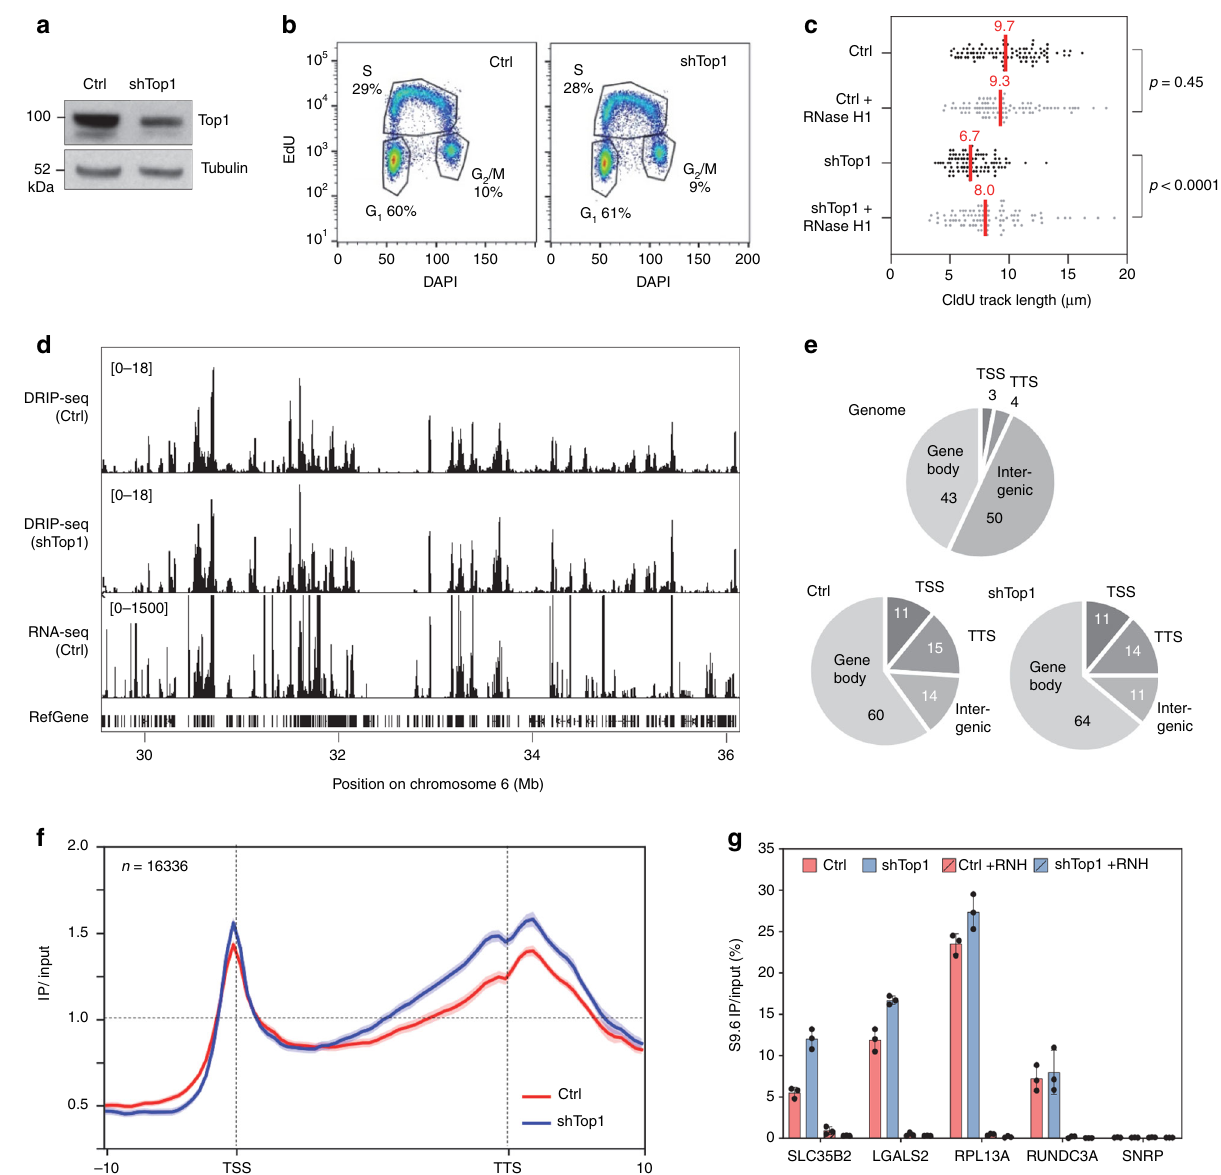
Fig. 1 Depletion of Top1 increases R-loop formation and slows down fork progression. a Western blot analysis of Top1 levels in HeLa cells expressing shRNA targeting Top1 (shTop1) under the control of a doxycycline-inducible promoter at 72 h post-induction ( n = 9). b Cell-cycle distribution of control and shTop1 cells determined by fl ow cytometry after labeling of S-phase cells with EdU. The fraction of cells in the different cell-cycle phases is indicated. See Supplementary Fig. 7 for gating strategy. c Doxycycline-treated control and shTop1 HeLa cells were transfected for 48 h with a mock vector (EGFP-N1) or human RNase H1-EGFP ( + RNase H1) and were sequentially labeled with IdU and CldU for 20 min. Replication fork progression was measured using DNA fi ber spreading as described in “ Methods ” section. The median length of CldU tracks is indicated in red. At least 150 fi bers of each sample were measured ( n = 3). P -values were calculated with the two-sided Mann – Whitney rank-sum test. d DRIP-seq analysis of the distribution of RNA:DNA hybrids expressed in RPKM (Read Per Kilobase per Million reads) in control and shTop1 HeLa cells. A representative region on chromosome 6 is shown. RNA-seq data (RPKM) for HeLa cells and gene positions (hg19) are also indicated. e Distribution of R-loop peaks relative to gene annotations in control and shTop1 HeLa cells. Peaks were obtained with MACS2 and were analyzed with CEAS (Cis-Regulatory Element Annotation System). The expected distribution in case peaks were randomly positioned in the genome is shown for comparison. The percentage of DRIP-seq signals present in each annotation class is indicated. TSS: Transcription Start Site (5 ′ -UTR and 3 kb upstream). TTS: Transcription Termination Site (3 ′ -UTR and 3 kb downstream). f Metaplot of the distribution of S9.6 signals (IP/input) along 16,336 active human genes (RPKM > 0) and fl anking regions (±10 kb) in control (red) and shTop1 (blue) HeLa cells. Error bars correspond to SEM. g DRIP-qPCR analysis of the relative enrichment of RNA:DNA hybrids at the TTS of four genes and a negative control regions (SNPRN) in control and shTop1 HeLa cells after RNase H1 treatment ( + RNH). Error bars correspond to three independent